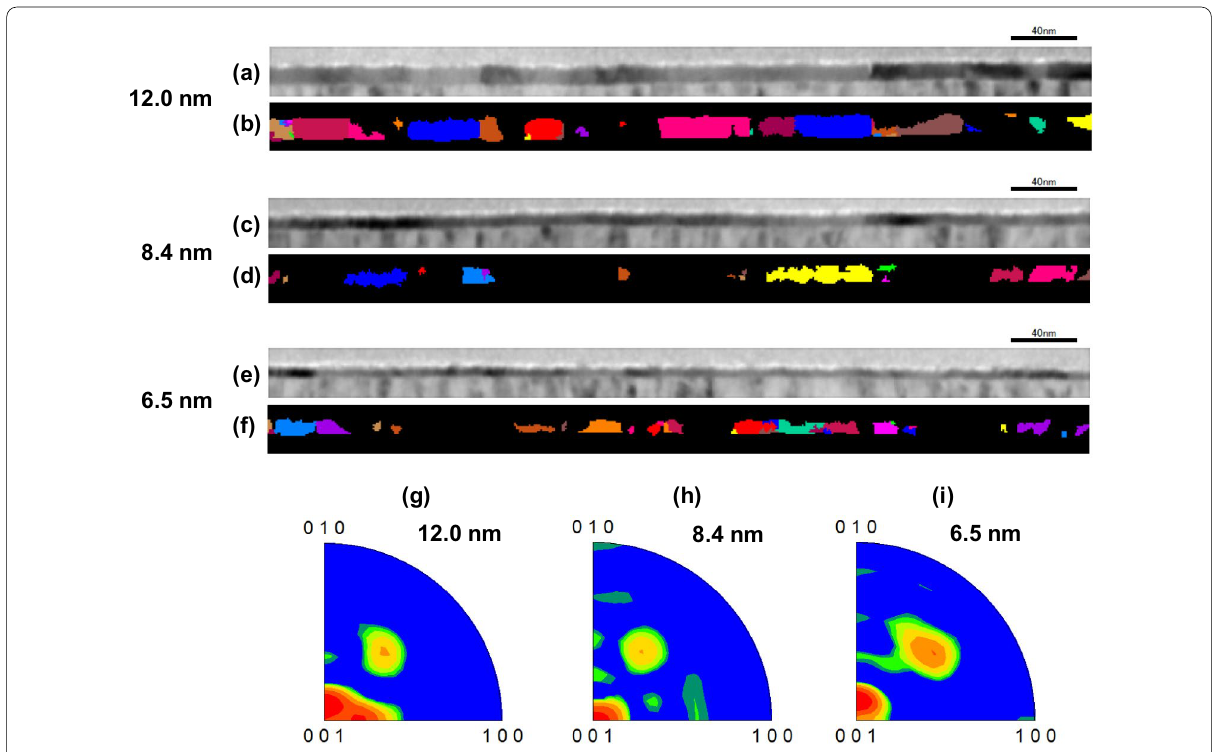
Fig. 7 Cross-sectional bright-field TEM images and f-phase grain maps for the ( a , b ) 12.0 nm, ( c , d ) 8.4 nm, ( e , f ) 6.5 nm-thick HZO capacitors. Inverse pole maps of orthorhombic grains for the ( g ) 12.0 nm, ( h ) 8.4 nm, ( i ) 6.5 nm-thick HZO capacitors with respect to the (001) orientation. The color represents the population of the orientations (red: highest, green: medium, blue: